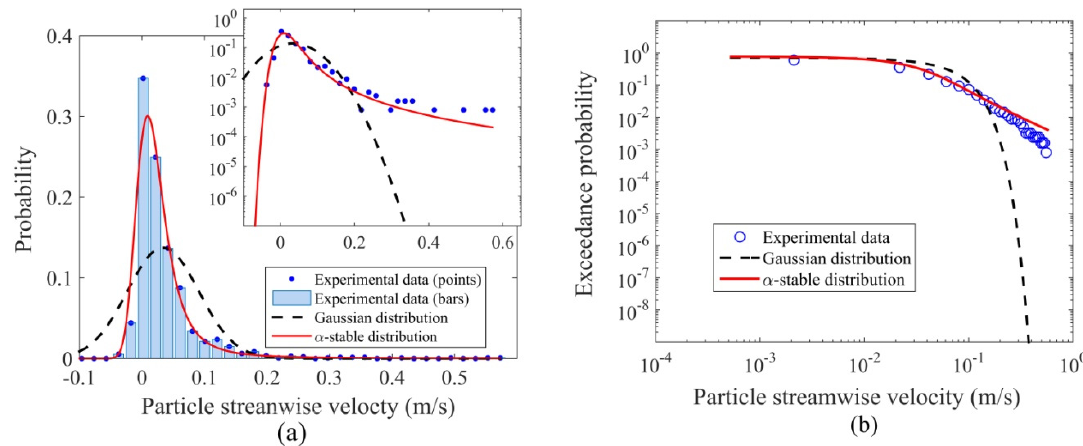
8 of 16 Figure 3. ( a ) Discrete probability distribution of the particle number activity for the interval Δ t = 1 s. The inset shows the same data with the fitted negative binomial and Poisson distributions on a semilog plot. ( b ) Exceeding probability of the particle number activity. 4.3. Particle Velocity The probability distribution of the streamwise particle velocity, Vx , was plotted in Figure 4. The probability distributions of the particle velocity were investigated in several previous experiments. Lajeunesse et al. [10], Roseberry et al. [13] and Shim and Duan [17]neglected negative streamwise velocities in their experiment data and found that the rest of the data were well fitted by the exponential distribution, whereas Martin et al. [11], Ancey and Heyman [41]and Heyman et al. [12] suggested that the particle velocity followed the Gaussian distribution. Fan et al. [20] used a hybrid mechanistic-stochastic model to analyze the bed load transport under low transport rates and found that the positive and negative streamwise velocities decayed exponentially at different rates. In our experiment, negative velocities accounted for almost 10% of the total V x measurements and therefore cannot be neglected. Therefore, we adopted the (thin-tailed) Gaussian distribution with exponential tails and the (heavy-tailed) α -stable distribution with power-law tails to describe the two-sided V x